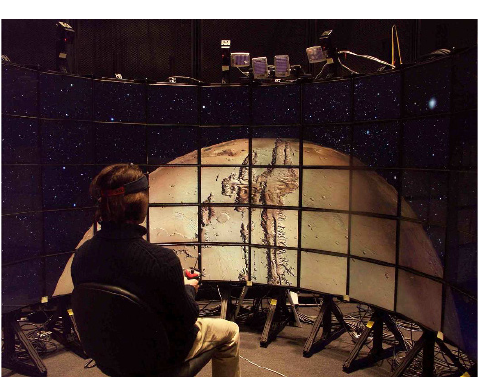
Figure 19. 60-panel Varrier autostereo display at Calit2. Mars data interactiverendering: BobKooima. Photo: TomDeFanti.